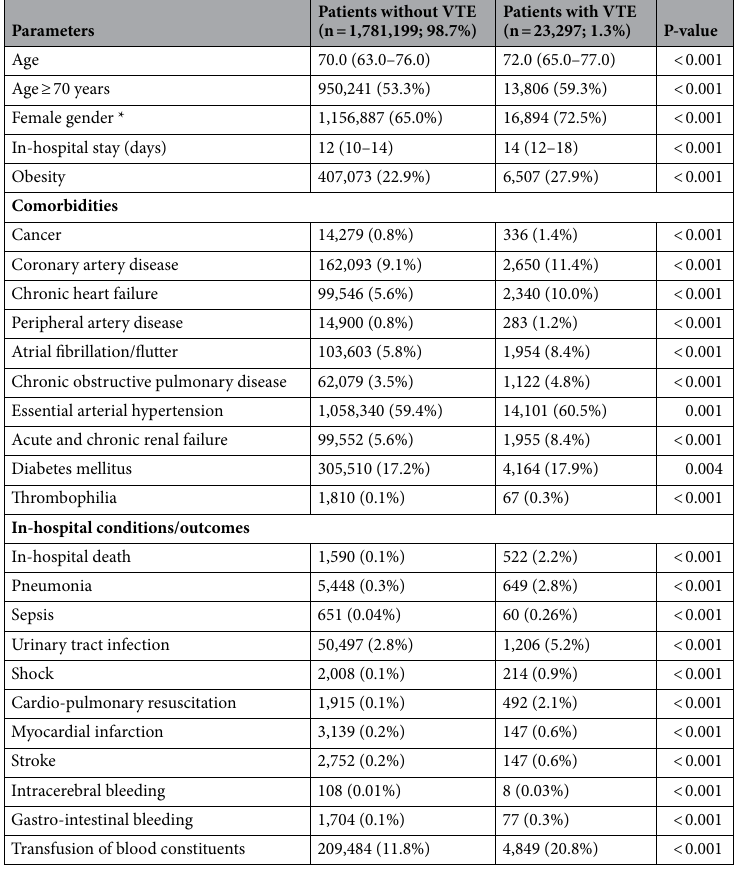
Table 1. Patient characteristics of 1,804,496 patients with elective KJR. *Data available for 1,804,428